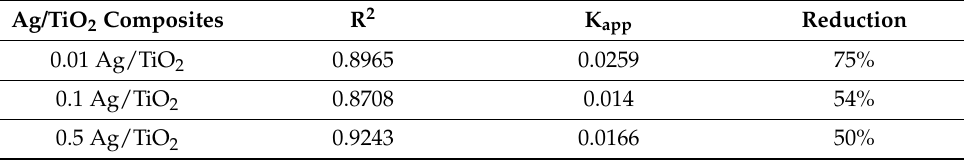
Figure 9. ( a ) The UV visible spectra of 0.5 Ag/TiO 2 composite of photocatalytic reduction of Cr (VI) Figure 9. (a) The UV visible spectra of 0.5Ag/TiO 2 composite of photocatalytic reduction of Cr (VI) to Cr(III). ( b ) The UV visible spectra of 0.1 Ag/TiO 2 composite of photocatalytic reduction of Cr(VI) to Cr(III). (b) The UV visible spectra of 0.1Ag/TiO 2 composite of photocatalytic reduction of Cr(VI) to Cr(III). ( c ) Photocatalytic reduction of Cr(vi) to Cr(III). ( d ) Comparison graph of 0.5 Ag/TiO 2 , to Cr(III). (c) Photocatalytic reduction of Cr(vi) to Cr(III). (d) Comparison graph of 0.5Ag/TiO 2 , 0.1 Ag/TiO 2 , and 0.01 Ag/TiO 2 composites. 0.1Ag/TiO 2 , and 0.01Ag/TiO 2 composites. Table 3. Kinetics study of photocatalytic reduction of Cr(VI) to